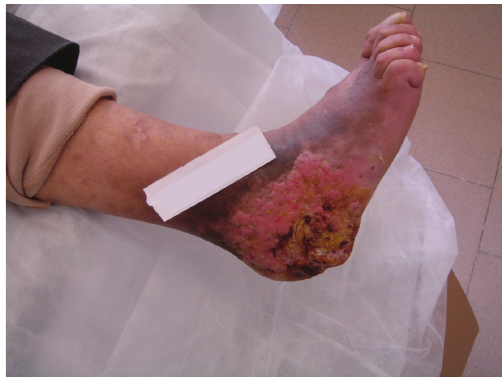
Figure 2: Verrucous carcinoma. This biopsy specimen shows well- differentiated neoplastic nests of squamous epithelium extending into the dermis.